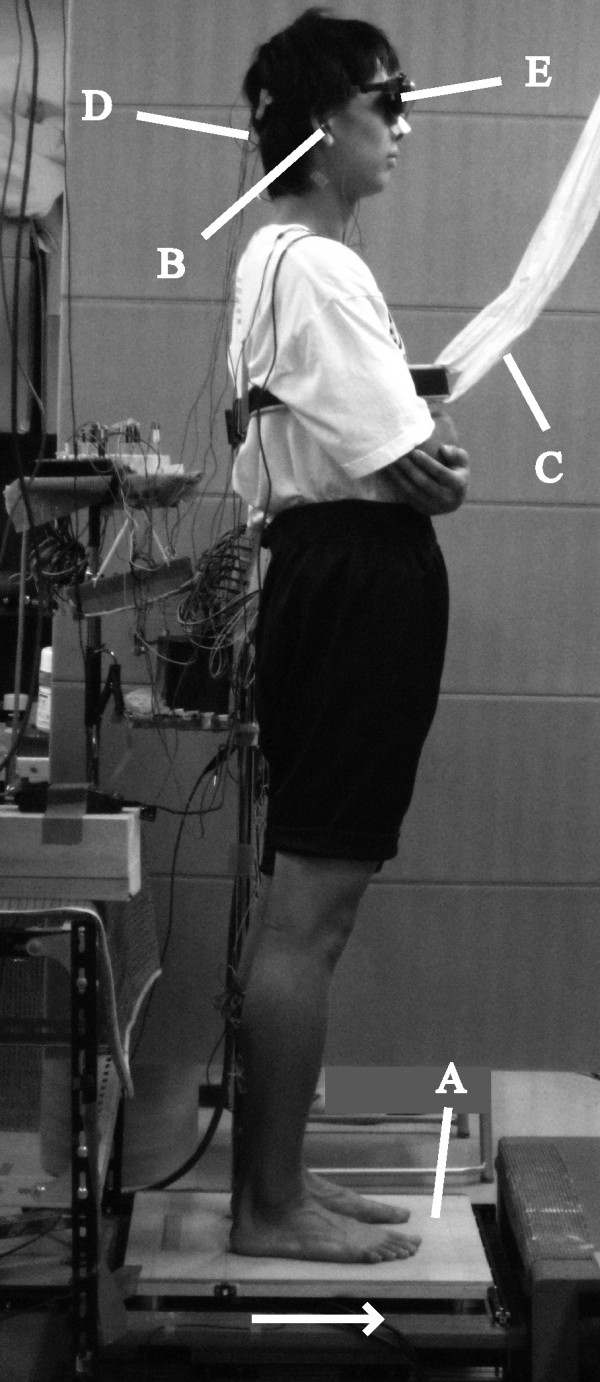
Experimental setup. A: platform, B: earphone, C: harness, D: Ag-AgCl cup electrodes, E: Eye-trek face-mounted display. Direction of platform movement is indicated by the arrow.